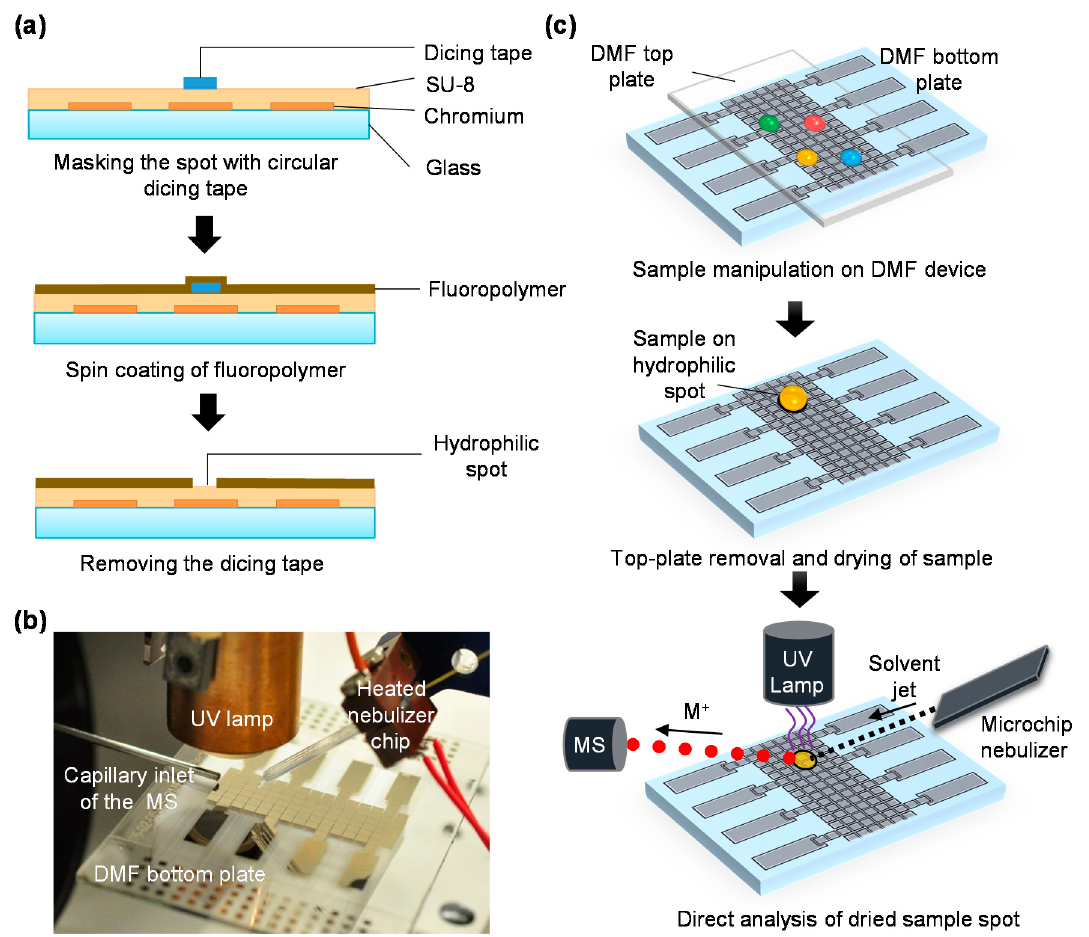
Figure 1. ( a ) Schematic view of the fabrication process of digital microfluidic (DMF) bottom plate incorporating hydrophilic spots, ( b ) a photograph of DMF-desorption atmospheric pressure photoionization (DAPPI) interface, and ( c ) schematic representation of the process flow of DMF-DAPPI-mass spectrometry (MS) analysis. For details of the heated nebulizer chip fabrication and use, see references [24,28], respectively.